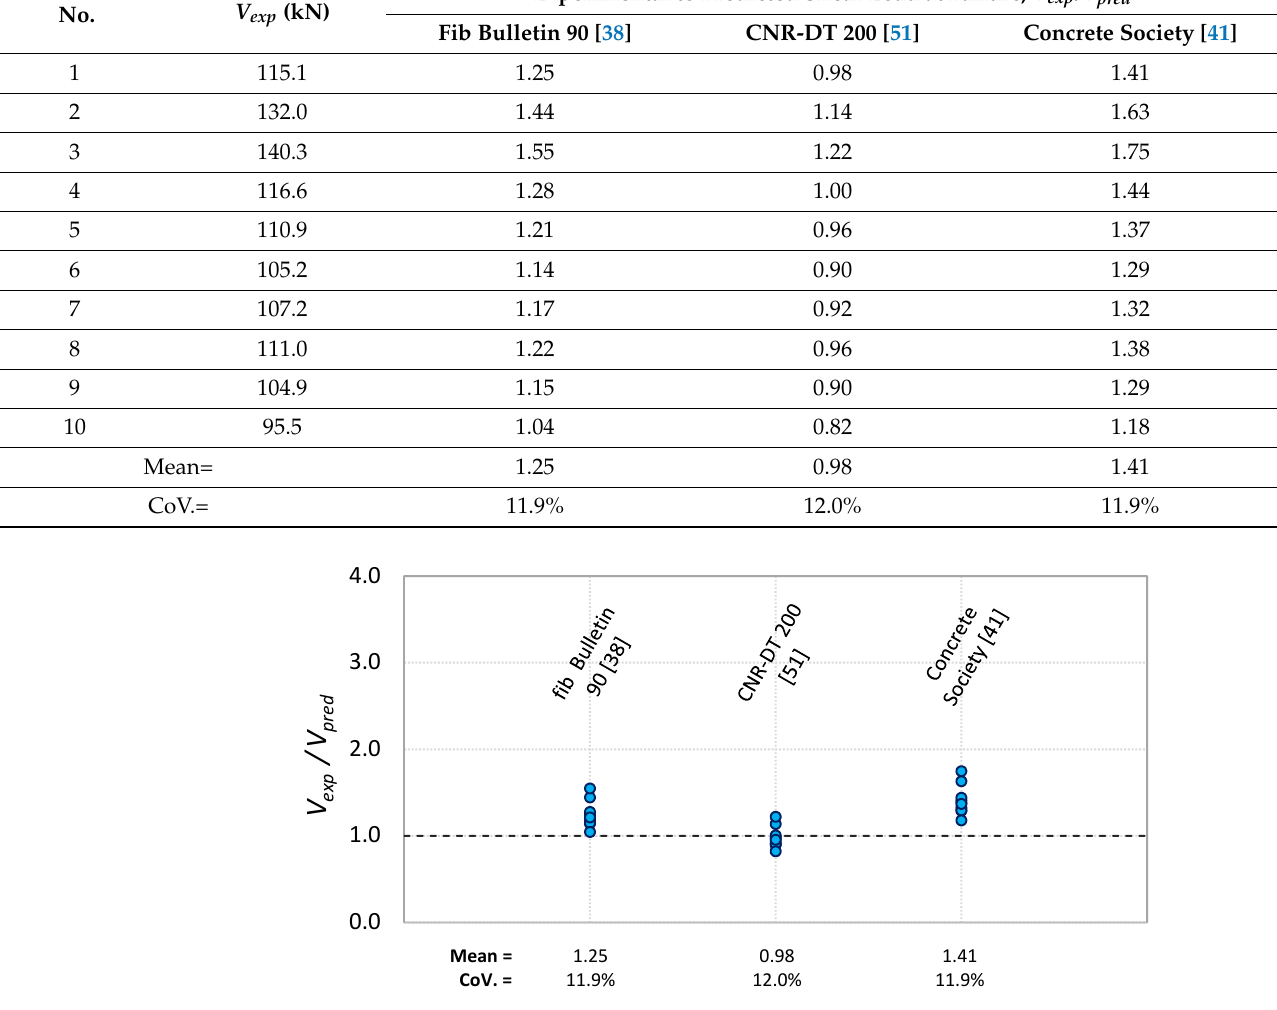
Table 7. Comparisons of fracture energy-based models given by codes for the prediction of plate end debonding capacity of the tested beams.